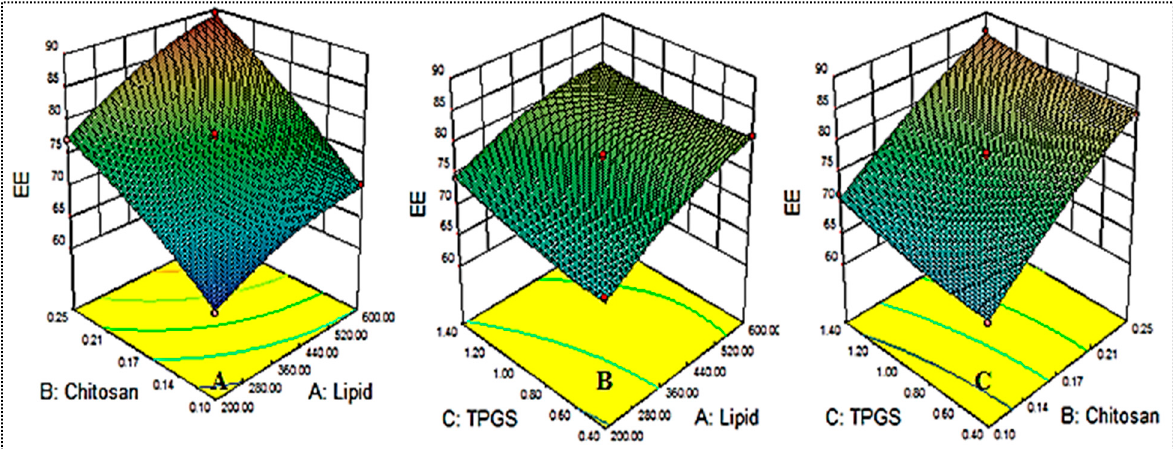
Figure 2. Effect of the constraints used (lipid ( A ), chitosan ( B ), TPGS ( C ) on entrapment efficiency (Y 2 ).